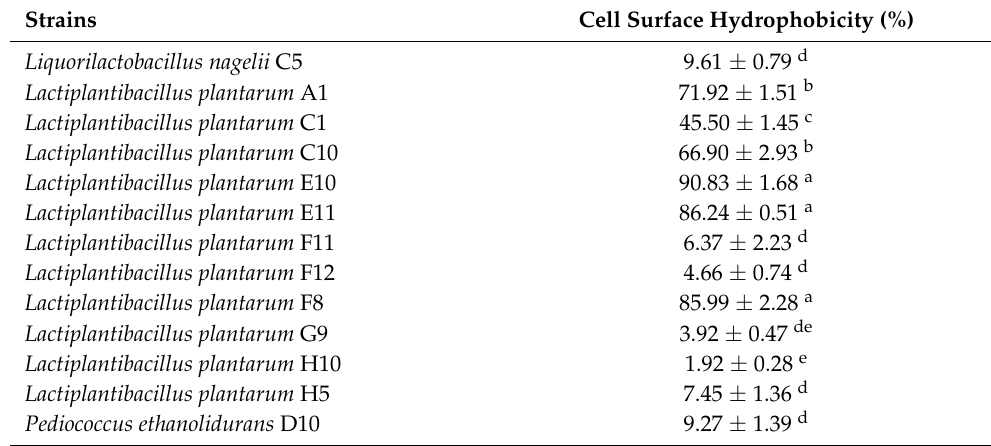
Table 5. Cell surface hydrophobicity of the LAB